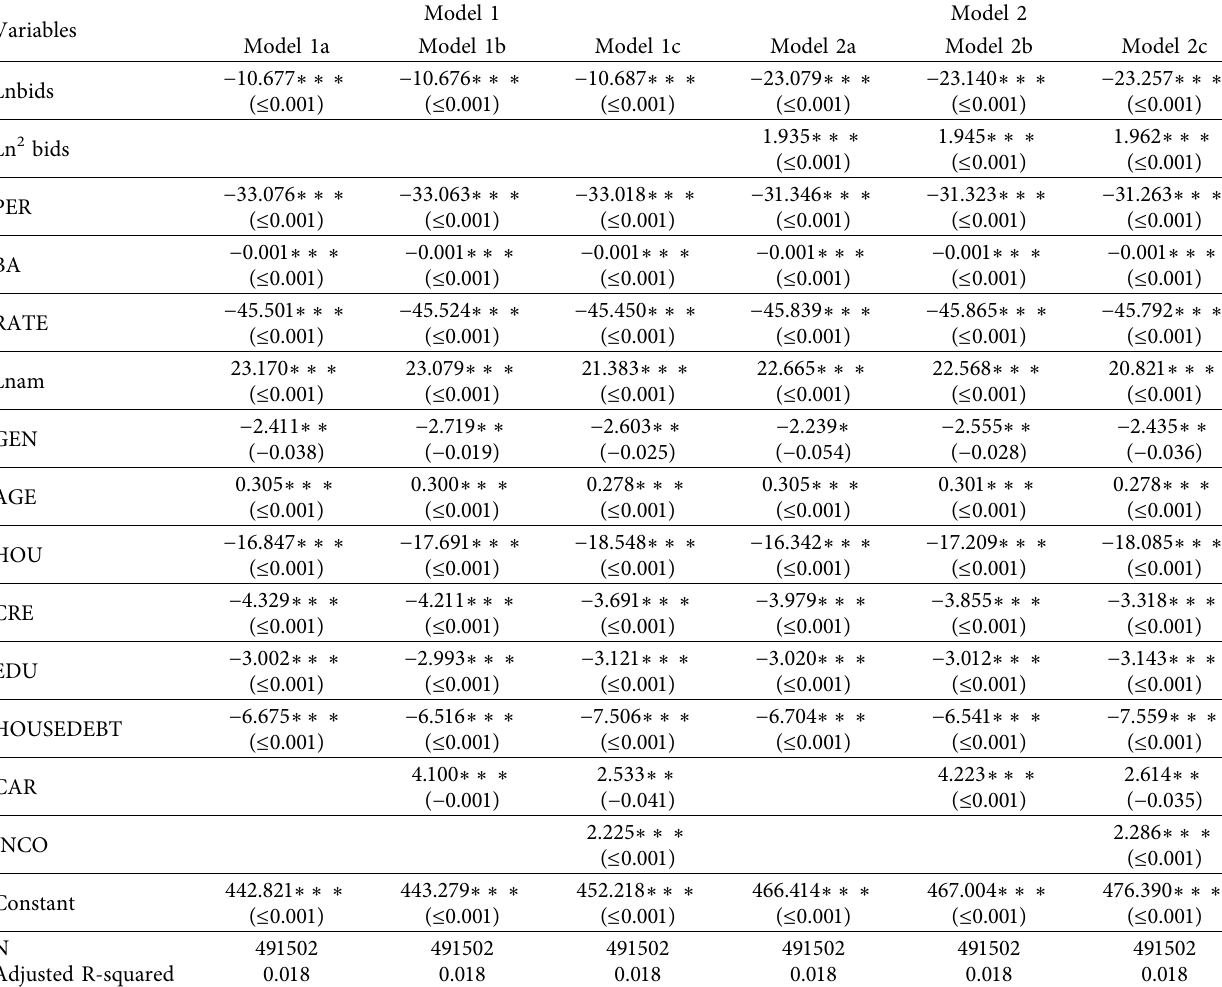
Table 8: Adding further control variables for model 1 and 2.